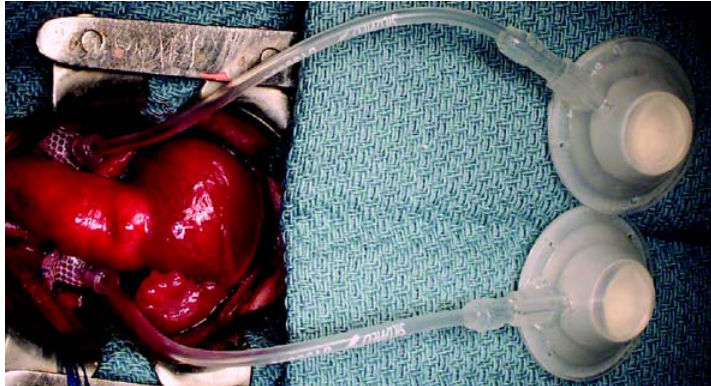
Fig . 2 - Bandagem bilateral das artérias pulmonares com o novo dispositivo ABS (4 mm), implantado através de esternotomia mediana. Os botões auto- selantes são implantados no subcutâneo da região